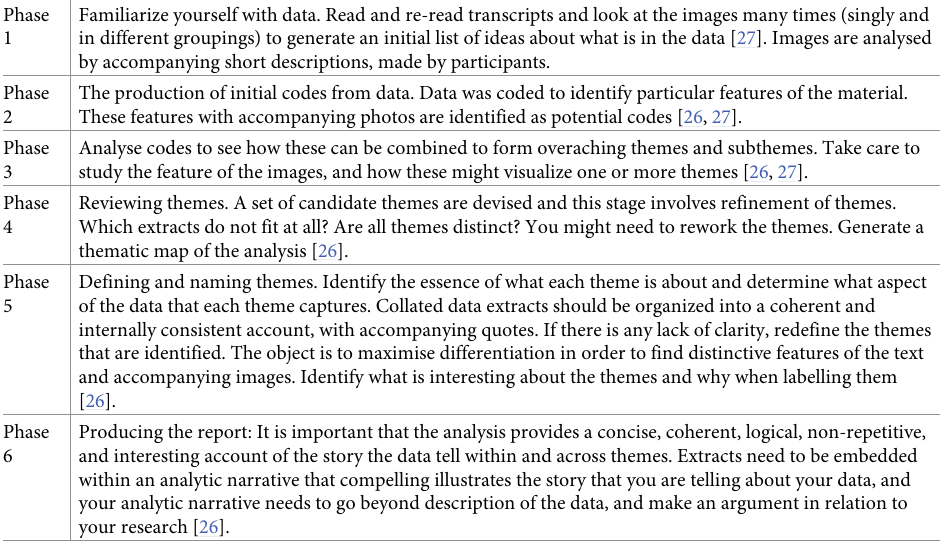
Table 2. An overall guide of the thematic analysis as outlined by Braun and Clarke [26] including features of an image-analysis [27]. Phase